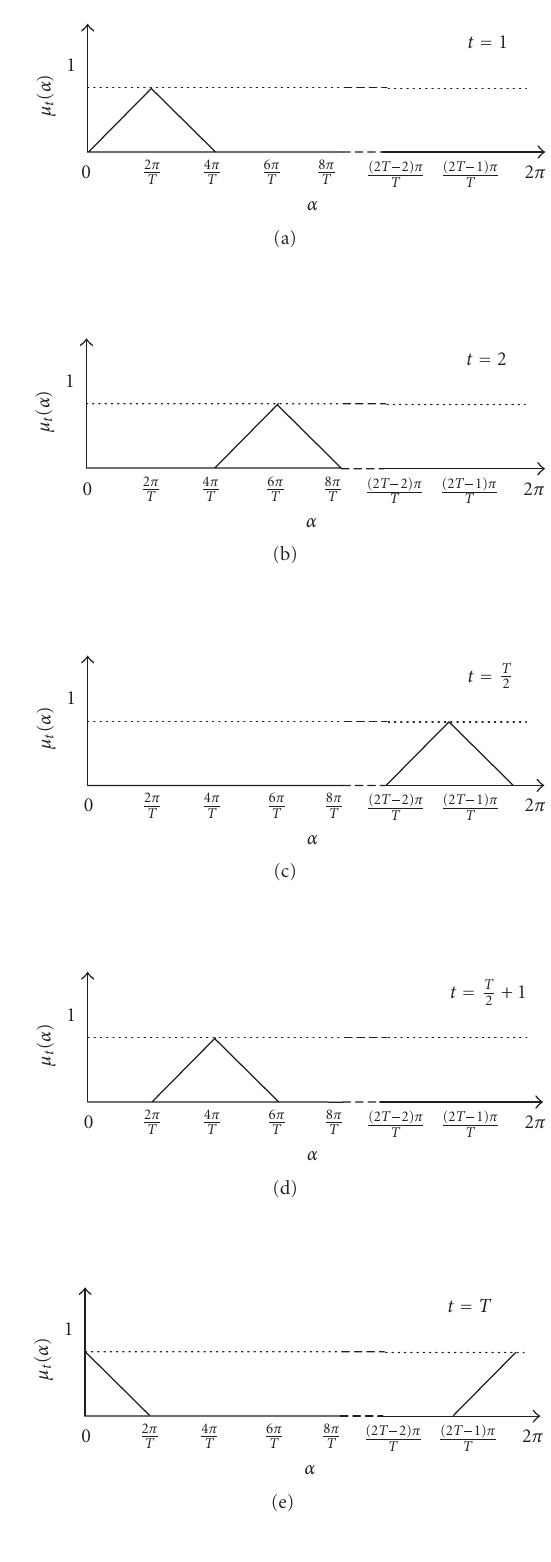
Figure 1: Geometrical interpretation of the weights selection in for- mula (4), α denote projection angle, μ t ( α ) denote the weighted of the projection data at α projection angle in t th subinterval, μ t ( α ) = 0, when t (cid:6)= [ α/ 4 π/T ] + 1, ([ x ] denote the integral part of x